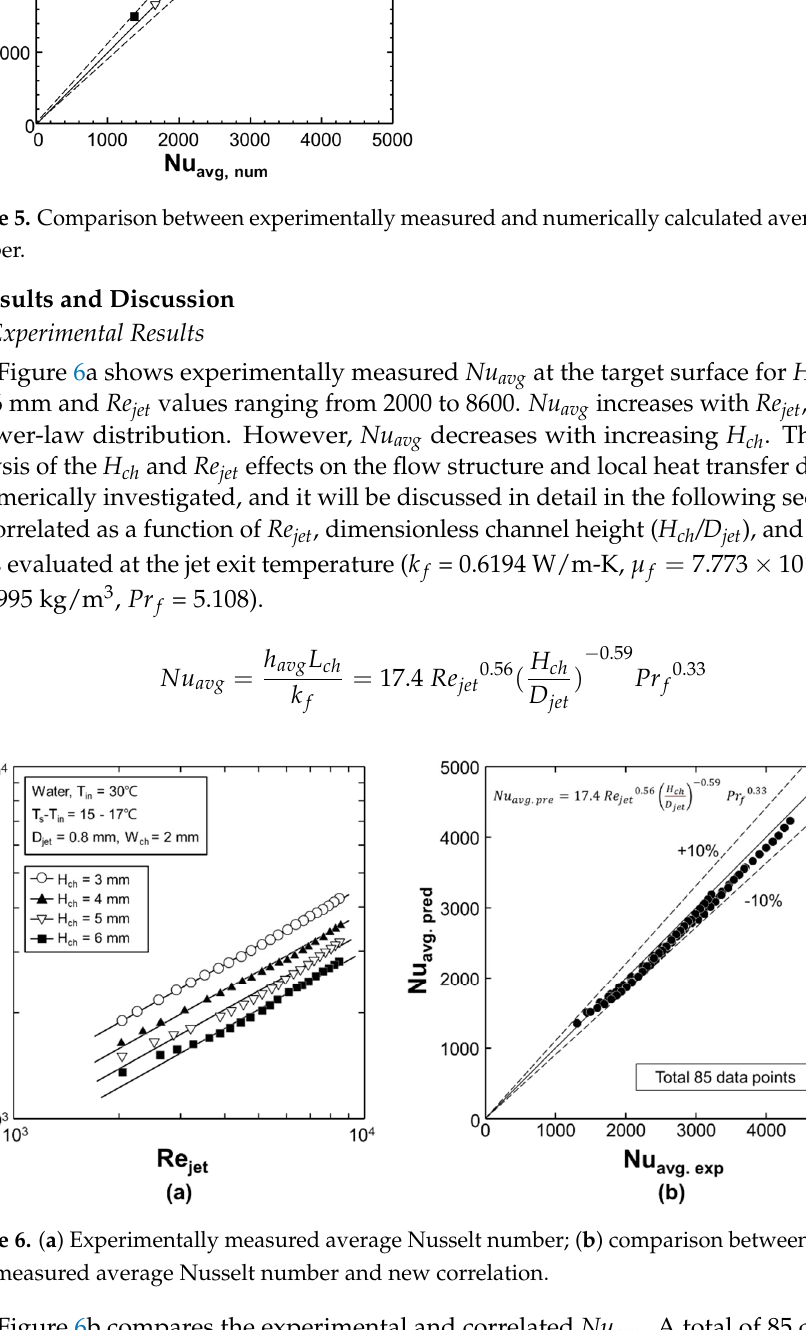
Table 4. H ch , V jet , and heat flux conditions for numerical analysis.